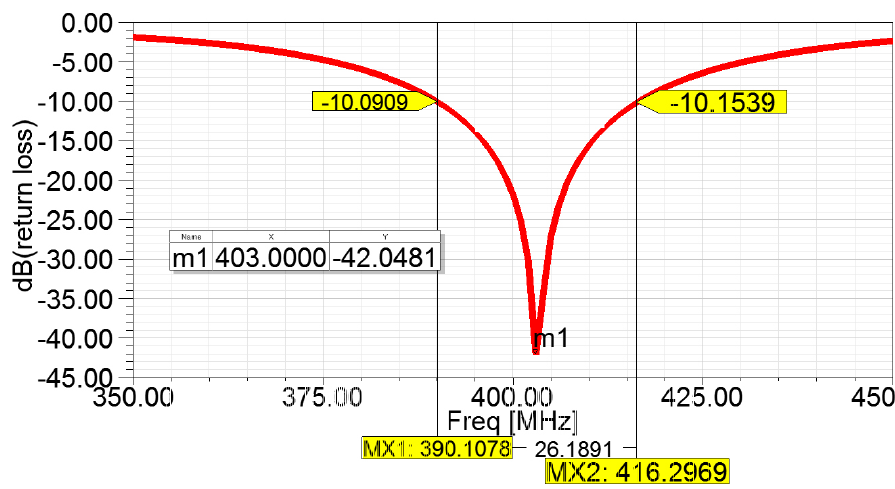
Figure 5. Return loss of final parameter.